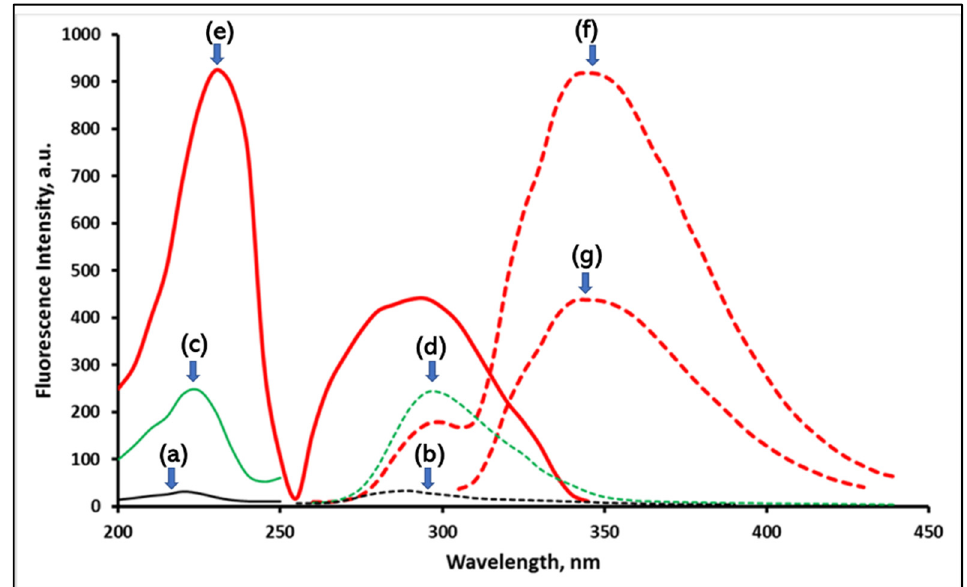
Figure 2. Excitation and emission spectra of NFZ alone (a, b), blank reducing agent (c, d), and reduced NFZ (e, f, g), where f and g represent reduced NFZ emission spectra after excitation at 230 and 295 nm, respectively. The excitation spectra are presented as solid lines, and emission ones are presented as dashed lines.